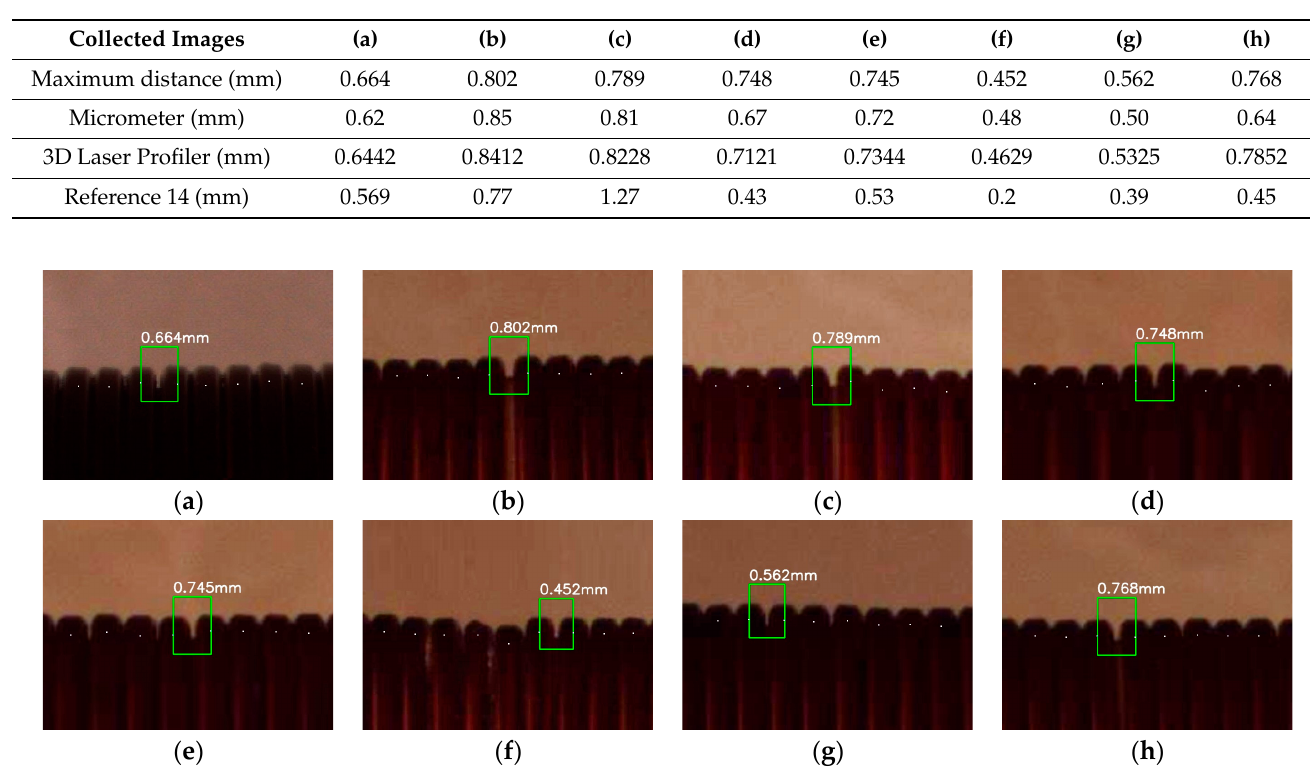
Table 1. The spacing test results are in Figure 24.